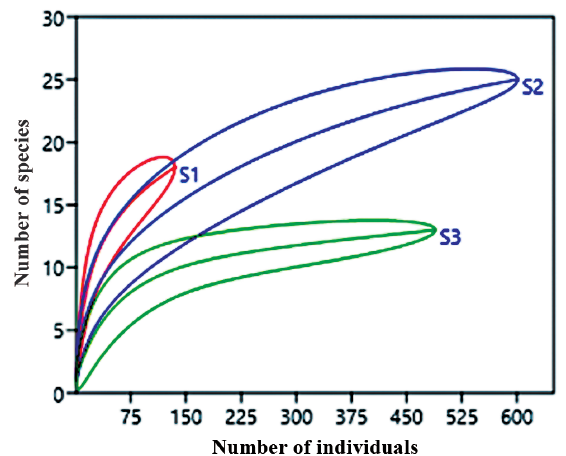
Figure 2. Species accumulation curves with their respective intervals of confidence for lake Nicola (S1), the water channel (S2), and lake Mangueira